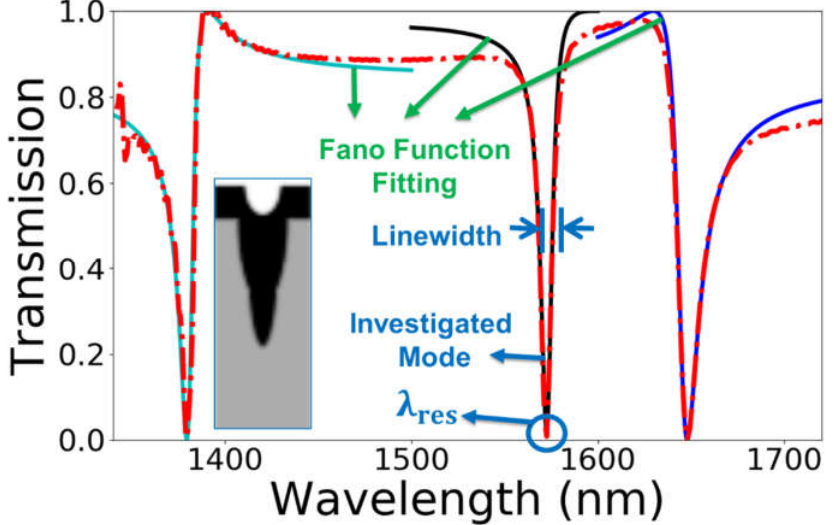
Table 1. The values of the parameters used in the Fano function to obtain the curve fitting for the three resonant modes are shown in Figure 3.